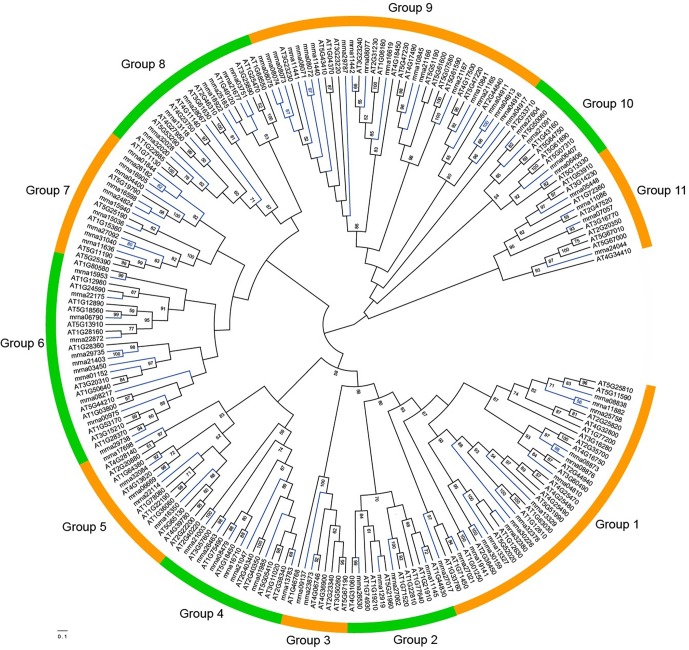
Maximum-likelihood phylogeny of the ERF proteins from Fragaria vesca and Arabidopsis thaliana. The phylogeny was constructed based on the amino acid sequences of full-length FveERF and AtERF proteins with 100 bootstrapping replicates. Bootstrap values greater than 50 are indicated on the nodes. Green and orange arcs indicate different groups of ERF proteins. Blue and black branches represent FveERF and AtERF proteins, respectively.